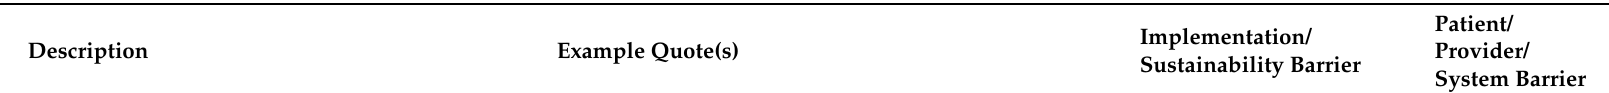
Table 2. Participant quotes demonstrating barriers to initiative implementation and/or